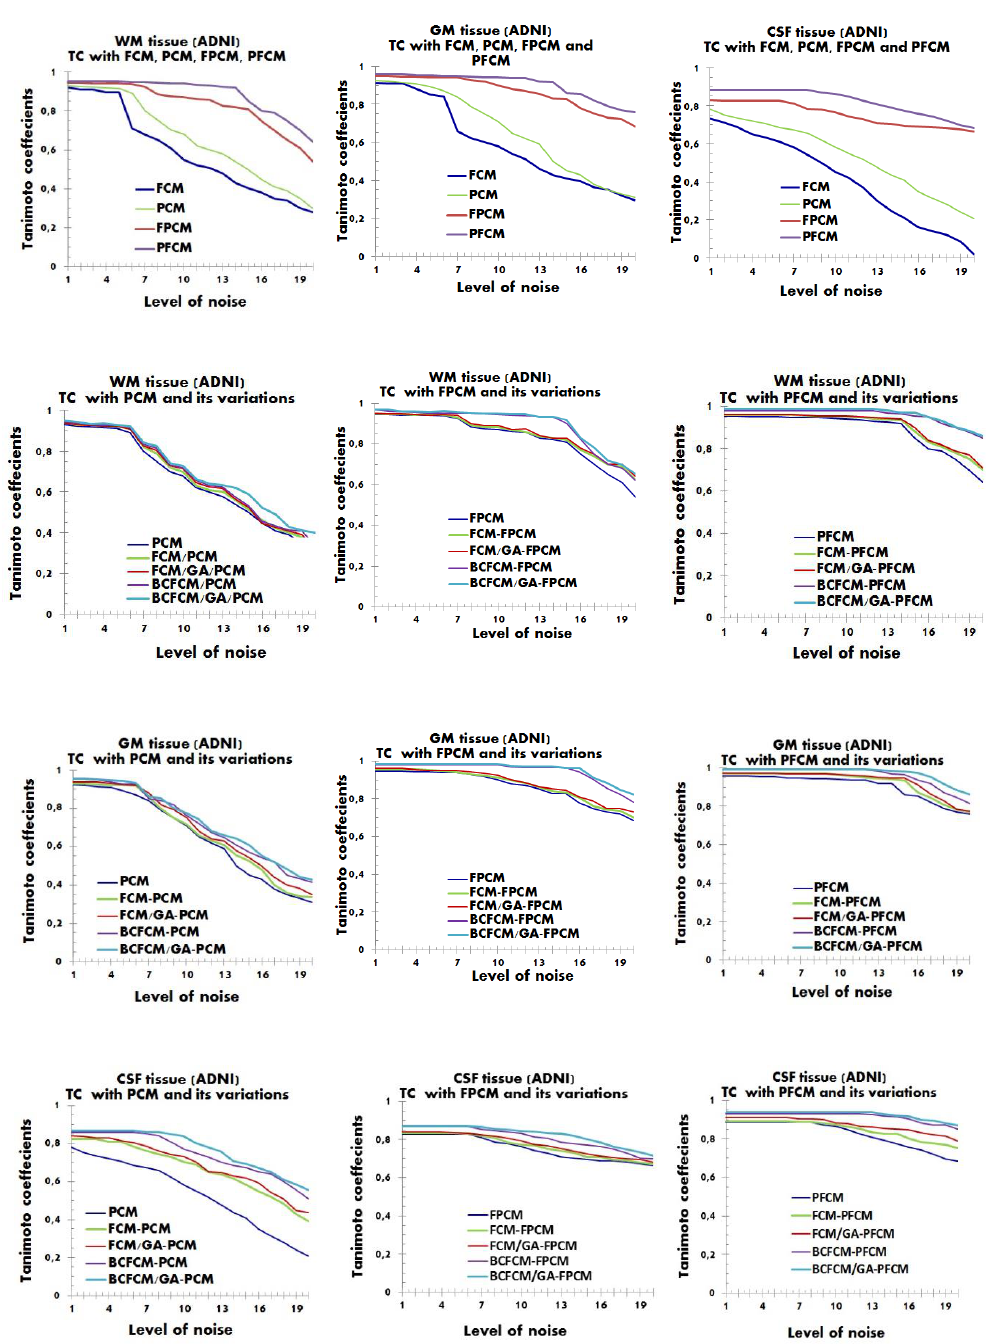
Figure 8. Curve of Tanimoto coefficients clustering index for WM, GM and CSF tissues with additive noise between 1% and 20%. Application with the hybrid approach BCFCM / GA / PFCM for an ADNI image. The results of modeling approaches from (1) to (15) are reported viz., (1) FCM, (2) PCM, (3) FCM / PCM, (4) FCM / GA / PCM, (5) BCFCM / PCM, (6) BCFCM / GA / PCM, (7) FPCM, (8) FCM / FPCM, (9) FCM / GA / FPCM, (10) BCFCM / FPCM, (11) BCFCM / GA / FPCM, (12) PFCM, (13) FCM / PFCM, (14) FCM / GA / PFCM, (15) BCFCM / PFCM. Legend: BCFCM: Bias corrected FCM; FCM: Fuzzy c-means; GA: Genetic algorithms; PCM: Possibilistic c-means; FPCM: Fuzzy PCM; PFCM: Possibilistic